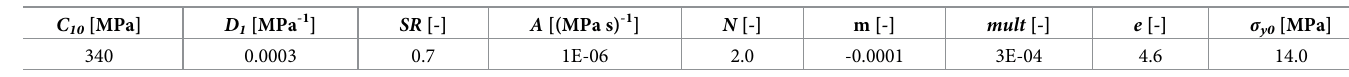
Table 2. Values of the parameters of the best material found with the calibration process.